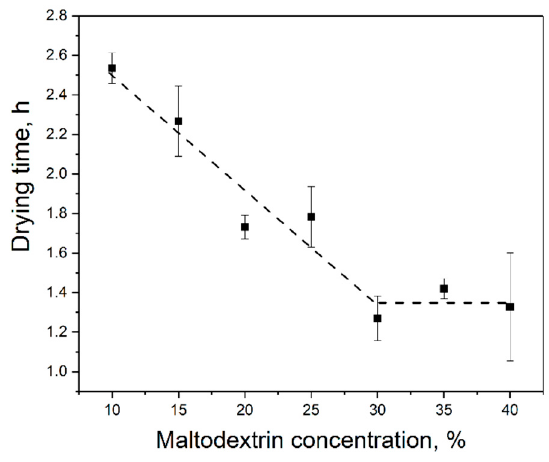
Figure 2. Drying time of polysorbate 80 foams as a function of the maltodextrin content.